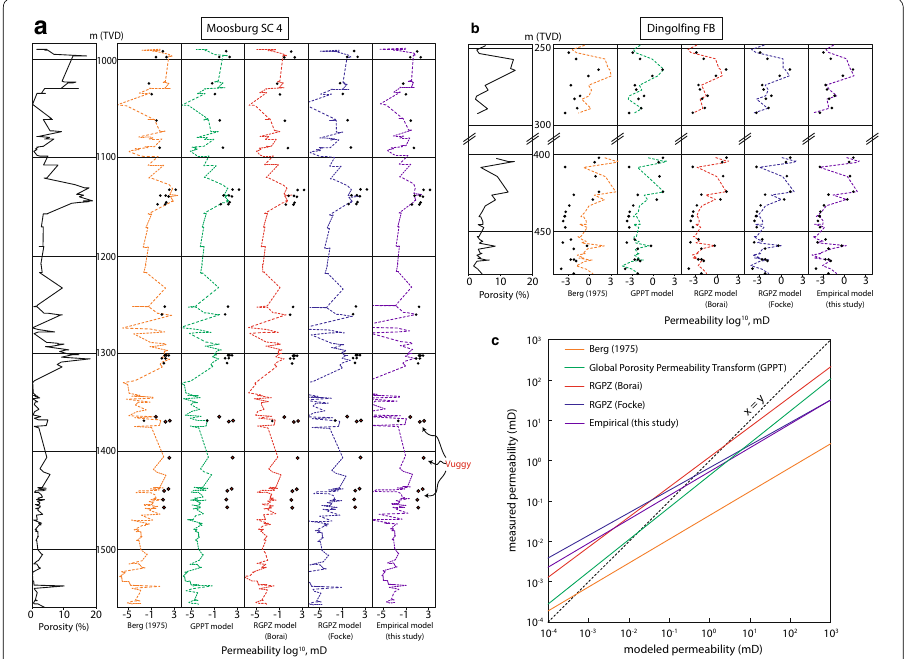
Fig. 12 Comparison of different permeability models with the permeability of rock cores. a Most models seem to underestimate the permeability compared to core permeability of the Moosburg SC4 well, especially in vuggy zones in the lower well section. b Besides the Berg model, all models show a relatively good fit for the well Dingolfing FB to permeability measured on rock cores. c Correlation of the measured and modeled permeability in a log–log plot to validate the model quality. The GPPT model seems to be the most reliable model based on the data